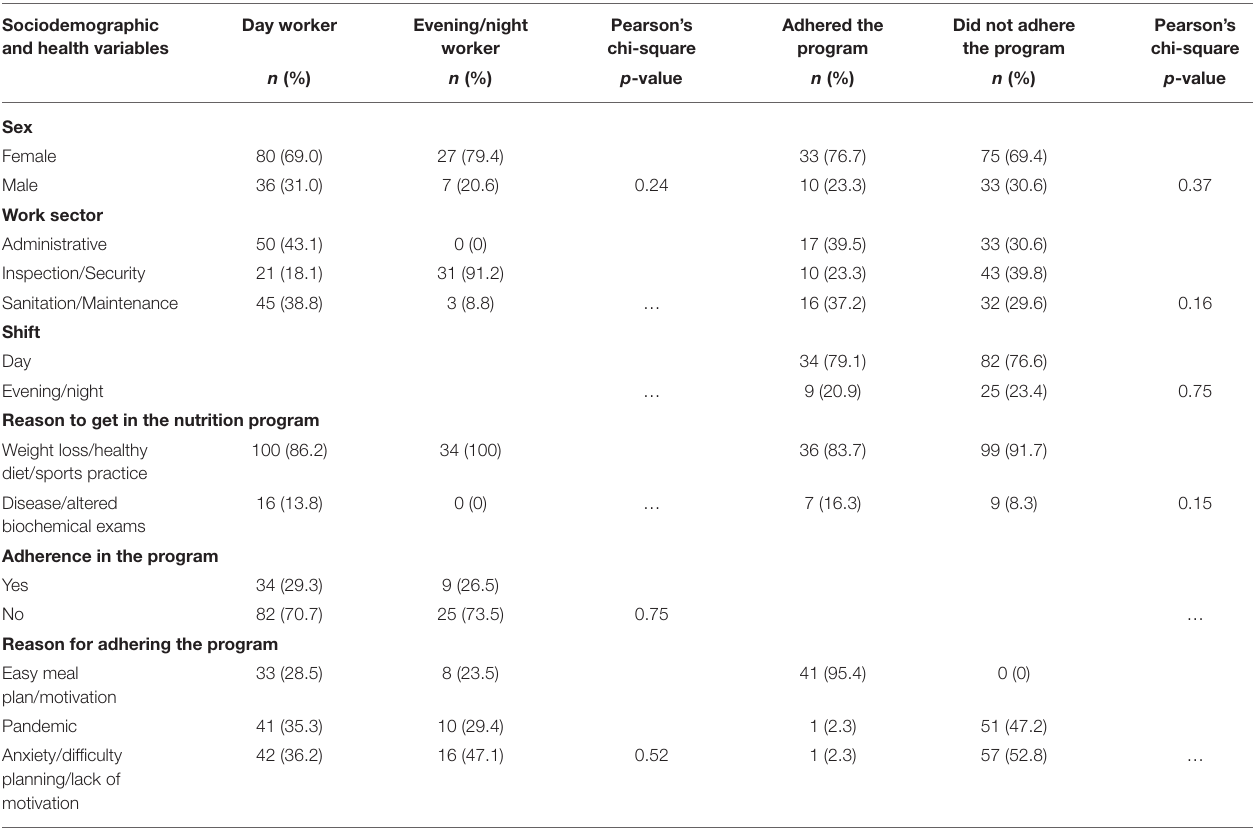
TABLE 1 | Sociodemographic variables by work shift and adherence to the dietary program. Sociodemographic and health variables